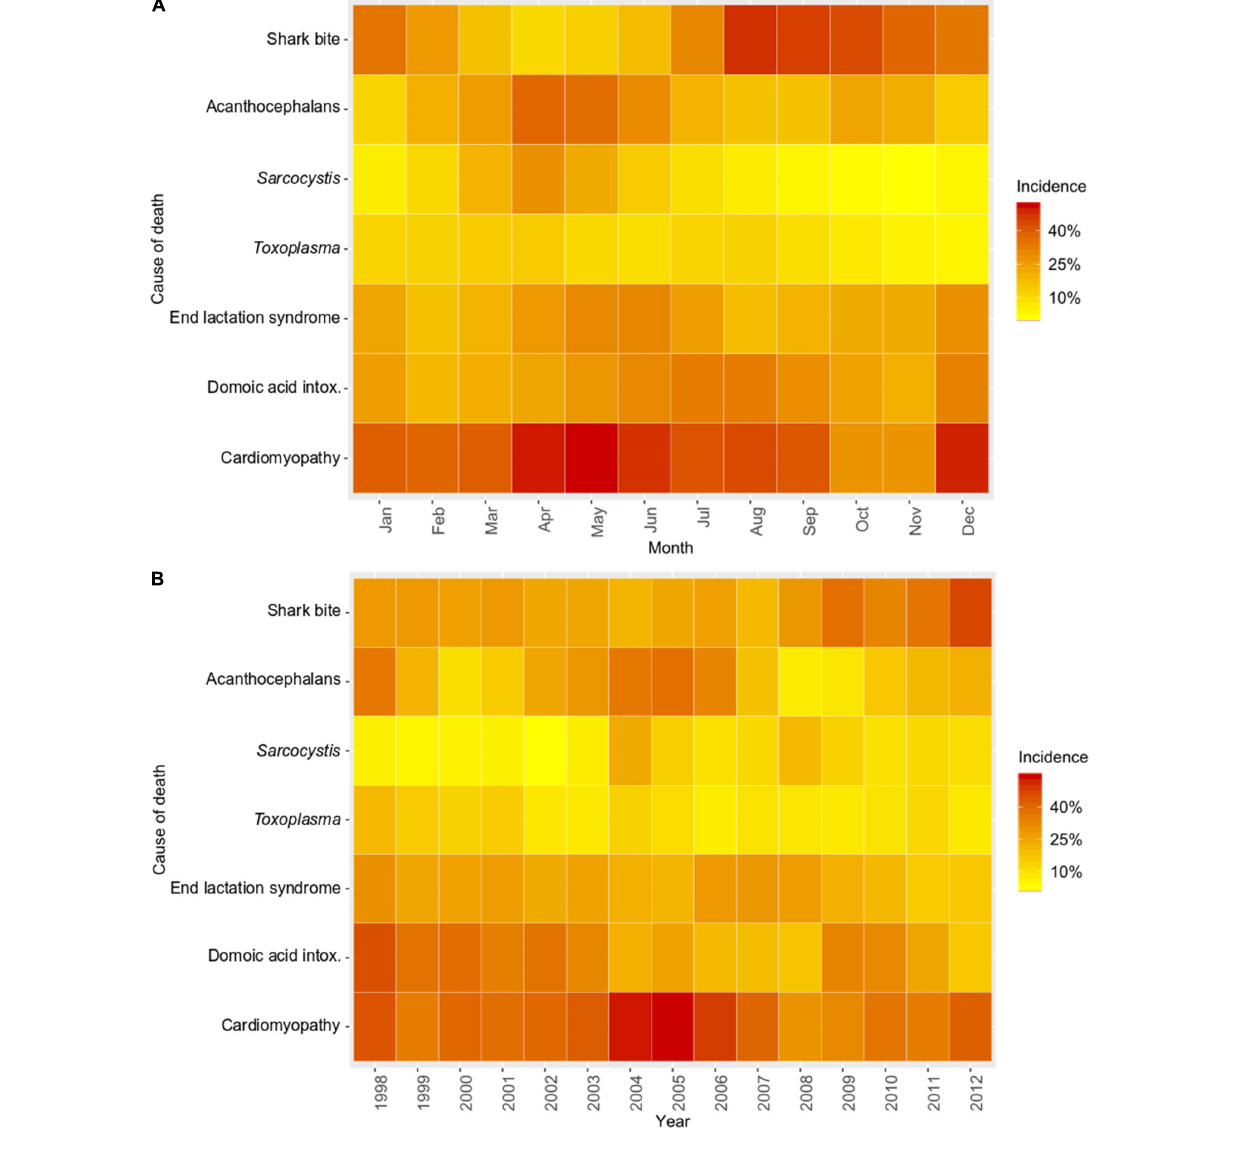
and over half (57%; 307/539) were infected with S. neurona ( Table 5 ). Over half (52%; 220/541) of otters with serological or histological evidence of protozoal infection were co-infected with both parasites ( Table 5 ), and 78% (421/541) of all sampled sea otters were infected with S. neurona, T. gondii , or both